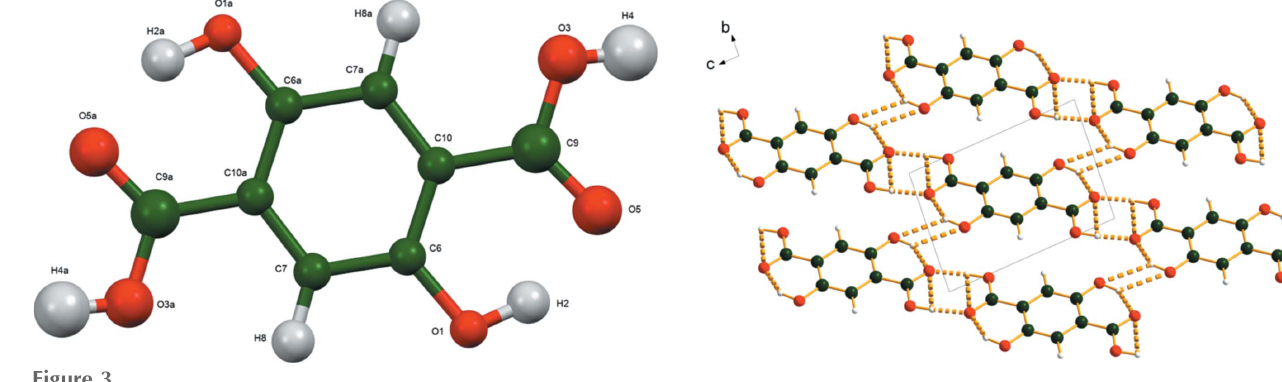
Figure 4 The crystal structure of anhydrous 2,5-dihydroxyterephthalic acid, viewed down the a -axis. Image generated using DIAMOND (Crystal Impact, 2022).